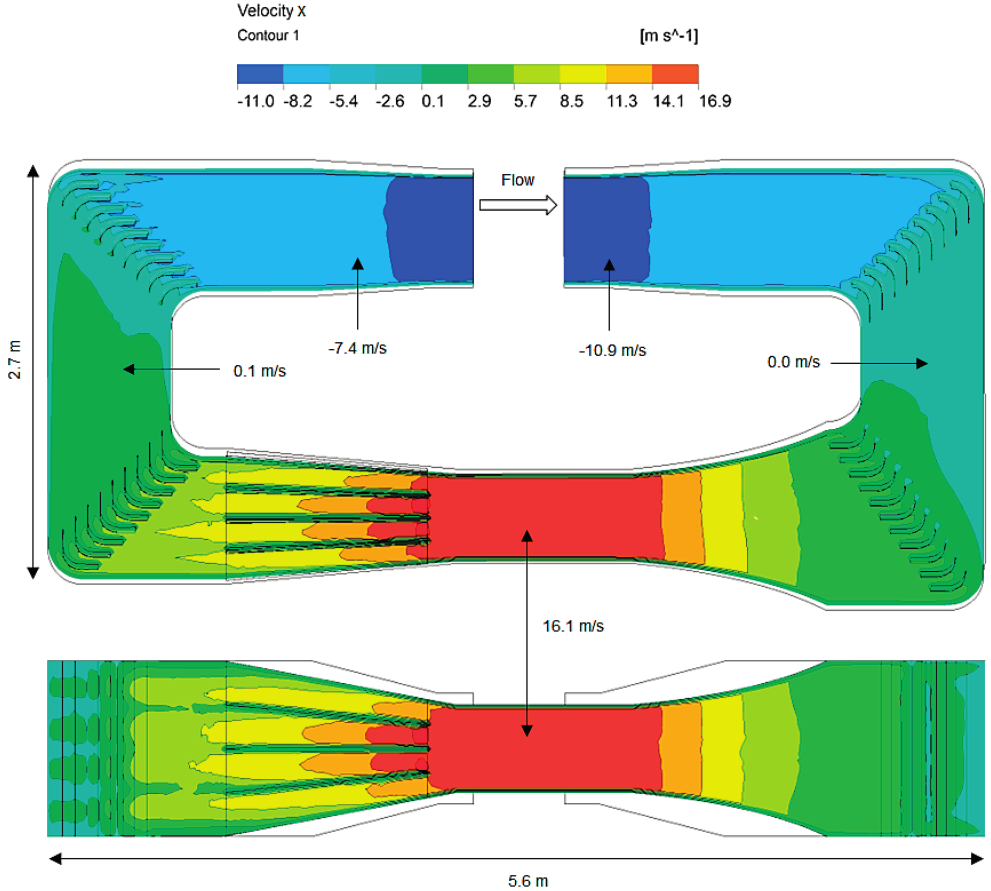
Figure 6. Air velocity across the front plane of the wind